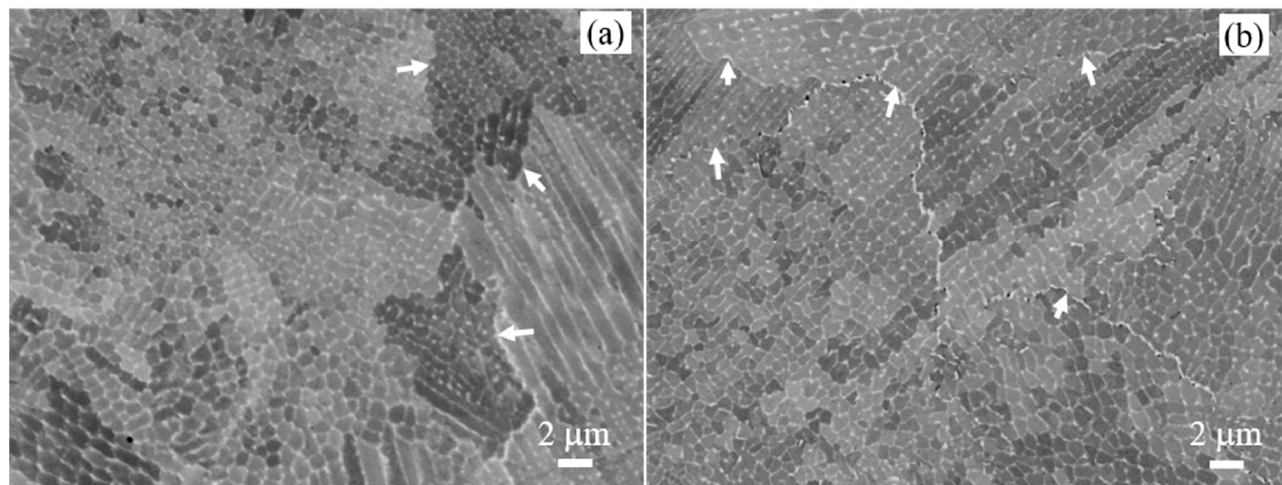
Figure 7. Electron backscatter SEM images: ( a ) as ‐ printed and ( b ) direct ‐ aged samples. The arrows are pointing to the grain boundaries in both images.